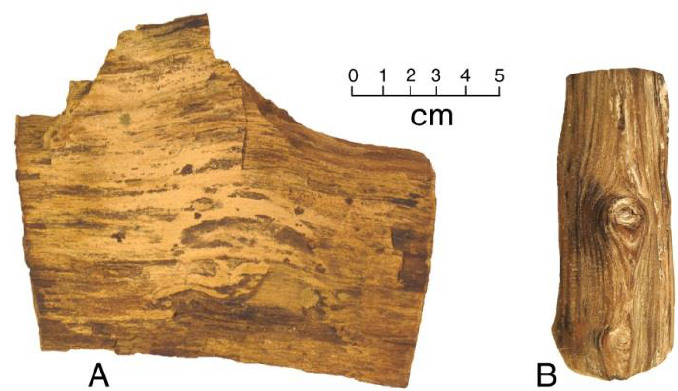
Figure 4. Miocene phosphatized wood. ( A ). Gooch Table, Virgin Valley, Nevada, USA; ( B ) Bruneau, Idaho, USA.